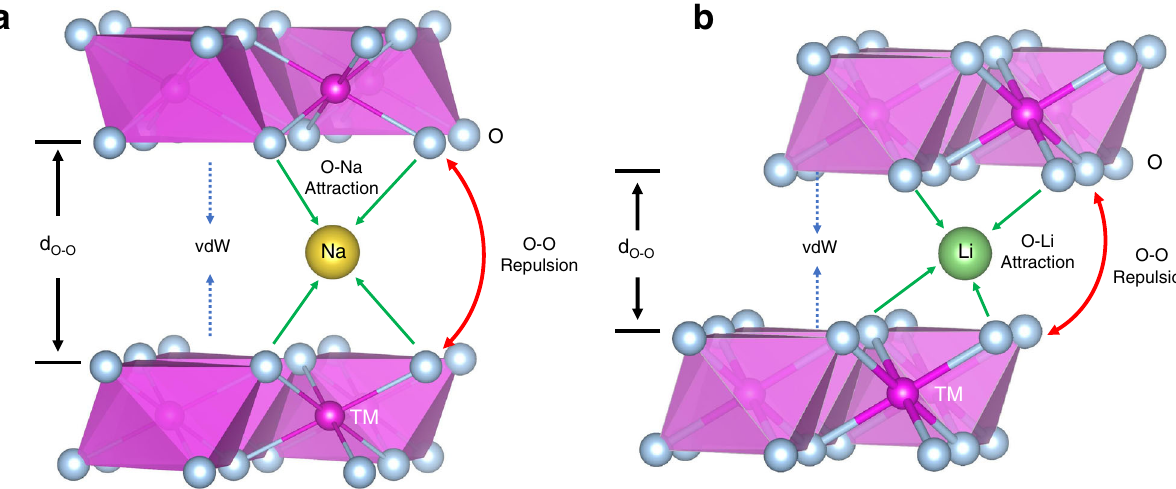
Fig. 1 Electrostatic interactions. Schematic illustration of the electrostatic interactions of a Na x TmO 2 and b LiTmO 2 .